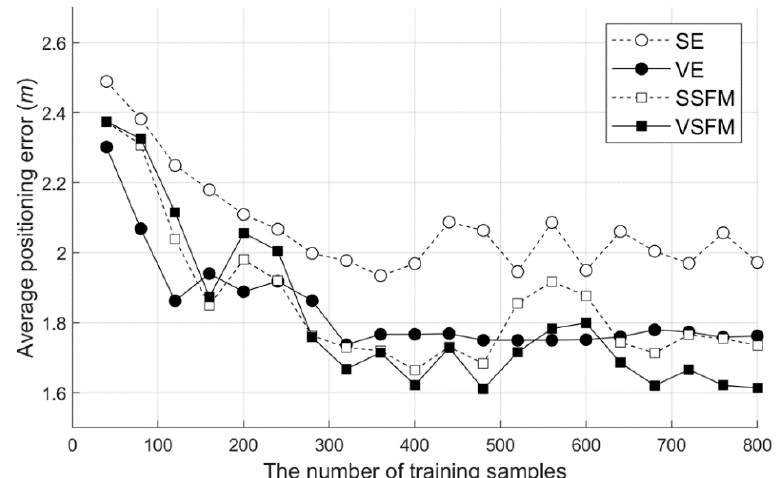
Figure 11. Positioning average error by the positioning algorithm. SE: Euclidean distance-based single positioning, VE: the basic Viterbi algorithm and Euclidean simultaneous use, SSFM: SFM-based single location, and VSFM: SFM-based location tracking.